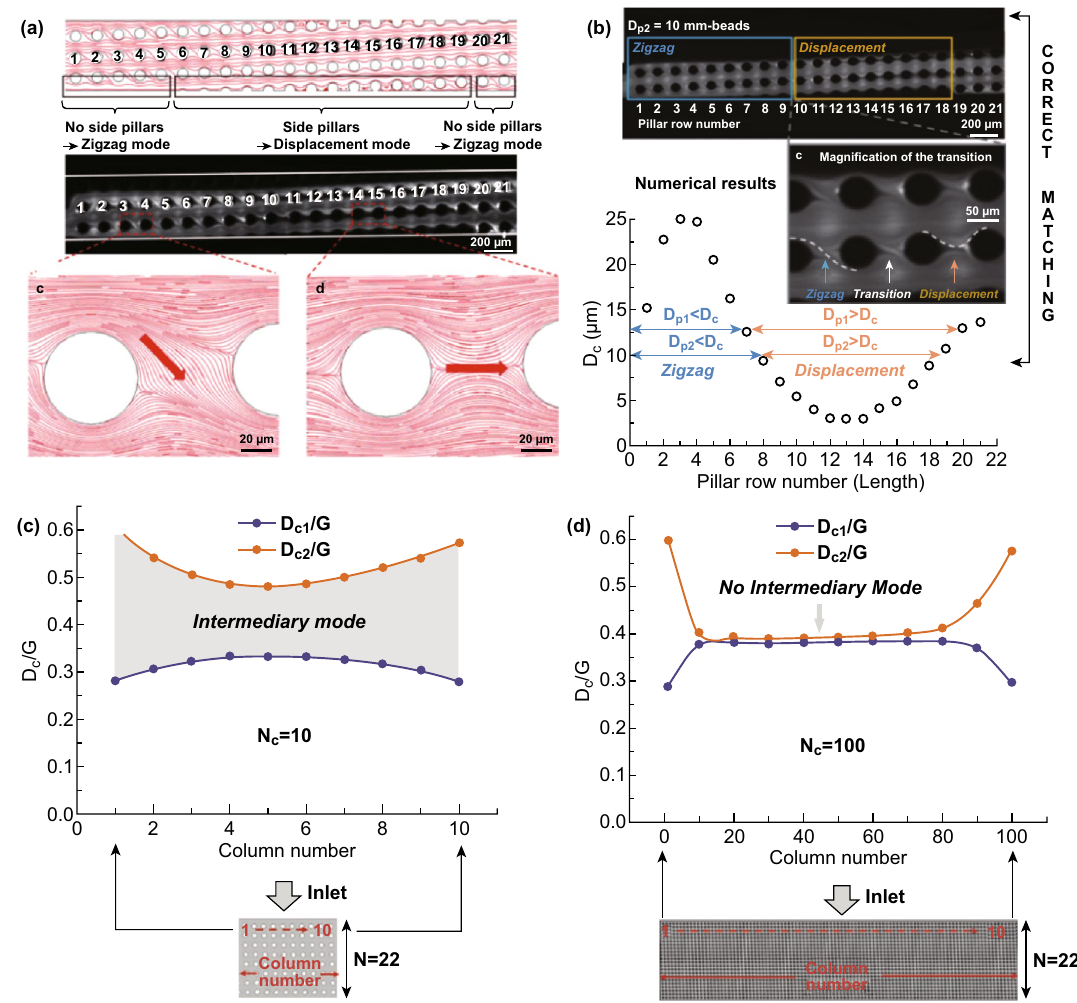
Fig. 6 a Sidewall effect on the particle separation: The regions without the side pillar induce the zigzag transition, while the sidewall regions with the side pillars induce the displacement mode trajectory. b The variation in the critical diameter with the pillar row number shows a peri- odic critical diameter value trend with the highest peak of D c1 and lowest peak of D c2 . c The value of D c1 / G and D c2 / G at different positions along the channel width in an array with N = 22 for ten pillar columns and d 100 pillar columns. Figure panels reproduced from Ref. [32]